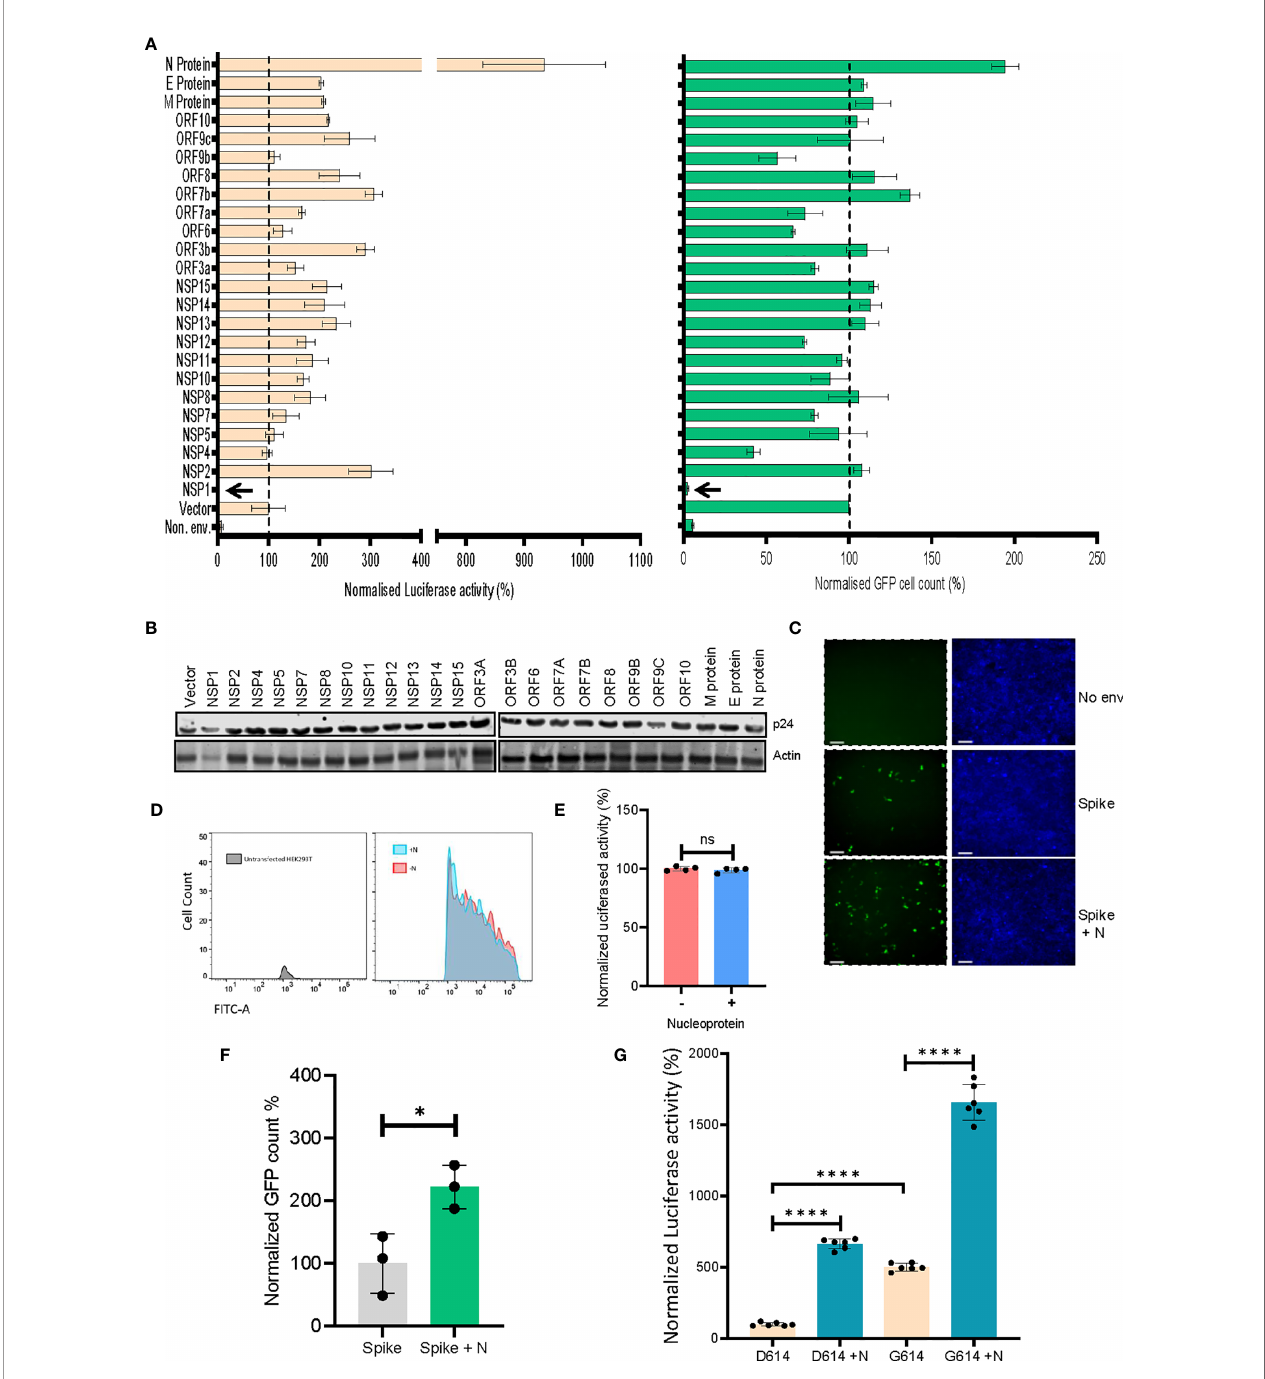
FIGURE 2 | SARS CoV-2 ’ s N protein enhances retroviral spike-pseudotyped particle infectivity. (A) . Results from the screen of SARS CoV-2 genes, either by quantifying luciferase activity (left panel) or GFP positive cell count (right panel). Vector normalized values for both readout methods has been shown, such as to indicate the percentage change relative to the baseline (indicated by the dotted line). Background signal levels are indicated by the non-enveloped (Non. env.) condition. n=4 ± SD. (B) p24 levels from the virus-producing cells for all the SARS CoV-2 genes were detected by Western blotting. Actin served as loading control. (C) Microscopy images for the infected cells with indicated conditions (scale 100 m m). (D) Representative fl ow cytometric analysis of the effect of N protein on Zsgreen expression, using populations transfected with either the reporter plasmid alone (red fraction) or along with the N protein (cyan fraction). (E) Quanti fi cation of the luciferase gene expression from the pScalps Luciferase Zsgreen reporter plasmid with and without the presence of N protein. n=4 ± SD. (F) Infectivity of MLV vector pseudotyped with the spike glycoprotein for both N-exclusive and N-inclusive conditions, normalized to the former. n=3 ± SD (G) Comparison between the infectivity of both wild-type spike and the D614G mutant, with and without N protein co-transfection, normalized to the wild-type spike-only condition n=6 ± SD. *p < 0.05; ****p < 0.0001; NS, Non signi fi